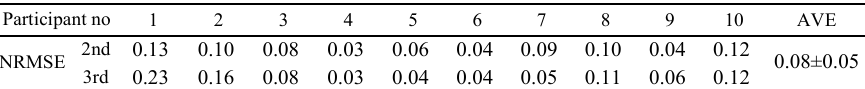
Eight parameters of the intrinsic model were identified using three pendulum trajectories with different release angles for each session of a participant. Table 3 summarizes, for each participant, the moment of inertia and the identified intrinsic parameters. All participants’ identified gravitational coefficients ( G ) proportional to the mass of the lower extremity was smaller than those of the non-spastic subject, which was about 15kg m/s 2 . (8),(10),(33) Most ) were higher than those of damping coefficients ( D ) and the elasticity-related constants ( k 1 normal (0.23 and 0.17, respectively). (8) The rest angle in a session slightly varied with